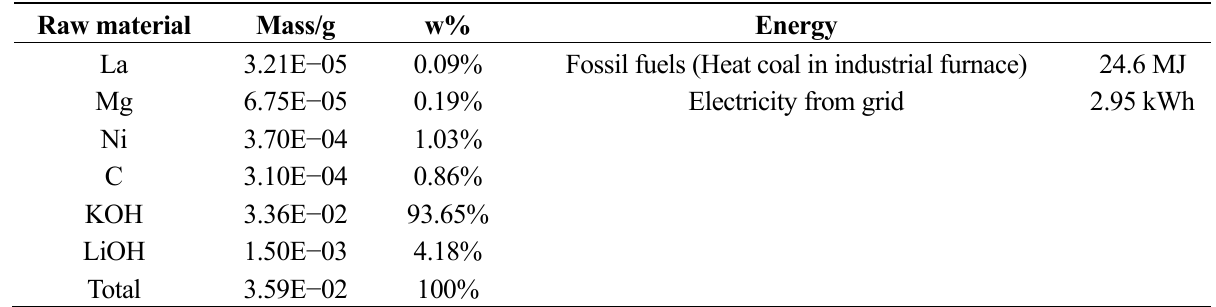
Table 2. The inventory of main raw materials (kg) and energy consumption for the Ni-MH battery (LaMg + 200% Ni alloy, 932.8 12